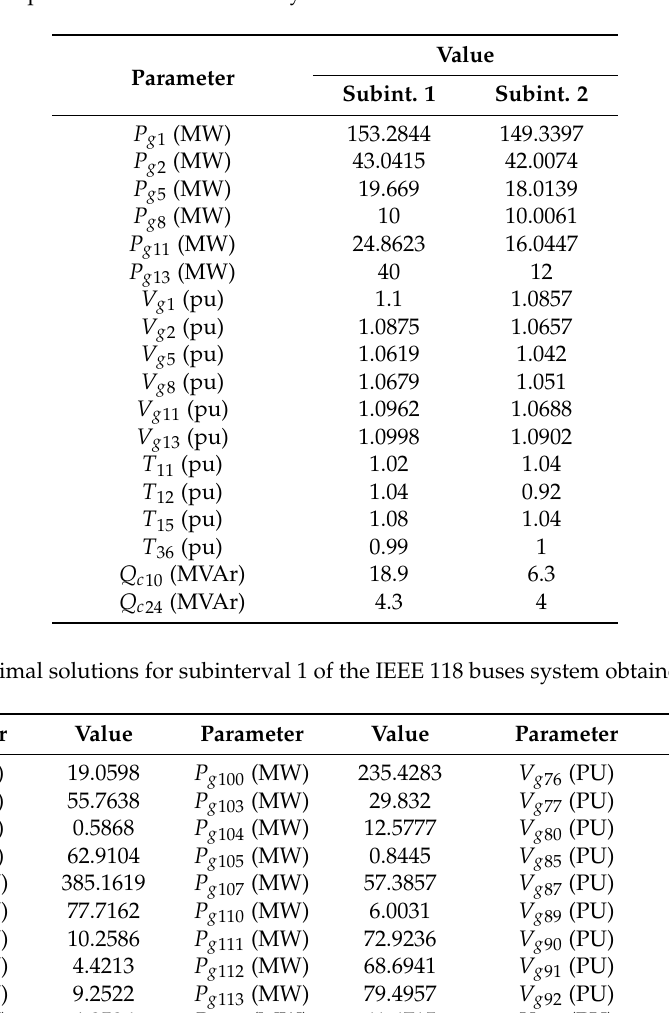
Table A4. Optimal solution obtained by ENCSA method for the IEEE 30 buses system.